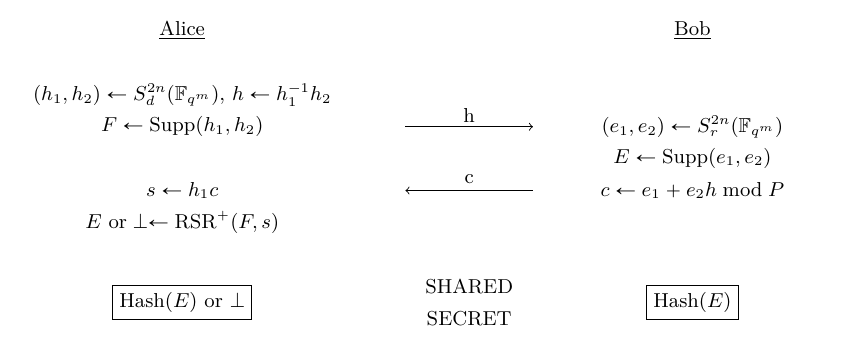
Figure 1: Informal description of ROLLO-I.